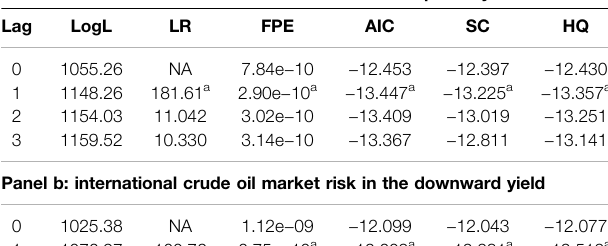
TABLE 3 | Selection of lag order in the VAR model. Panel a: international crude oil market risk in the upward yield